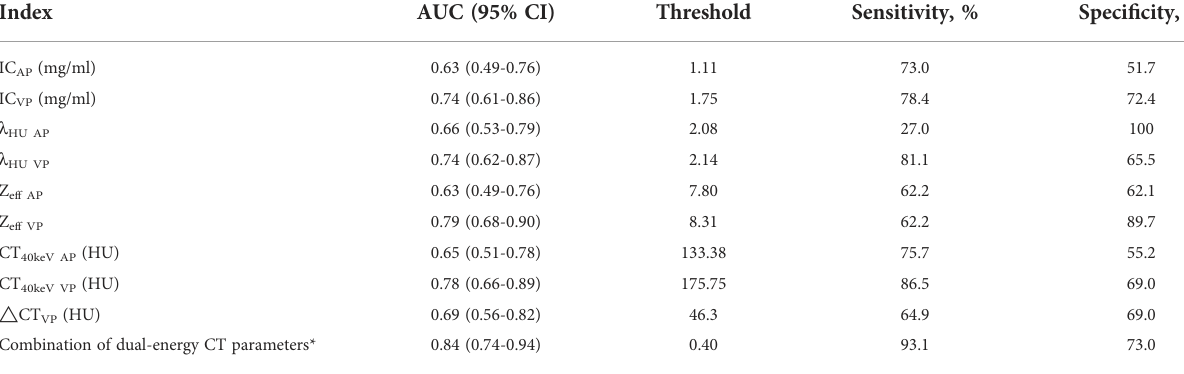
TABLE 3 Differential diagnostic ef fi cacies of Dual-energy CT parameters in AP and